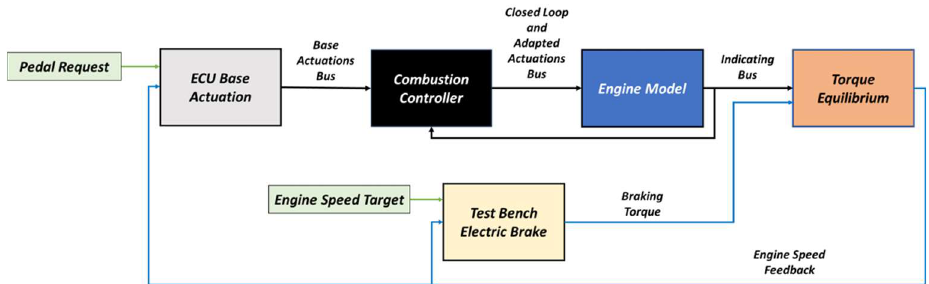
Figure 11. Schematic of Simulink control algorithm and the virtual model of the D98 engine. The Simulink model consists of five main blocks: